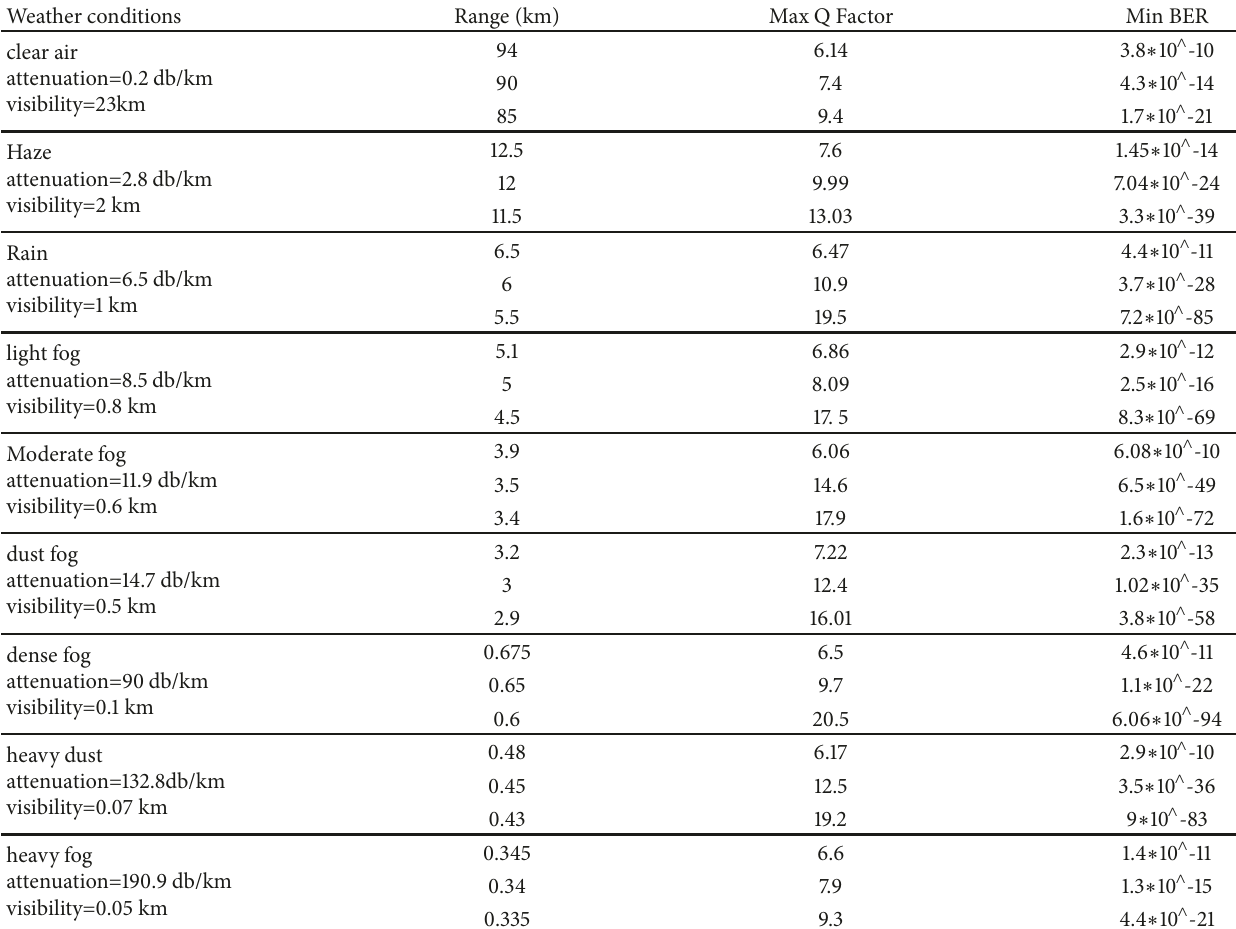
Table 3: Results for 1T X /1R X FSO at different weather conditions for 𝜆 = 1550